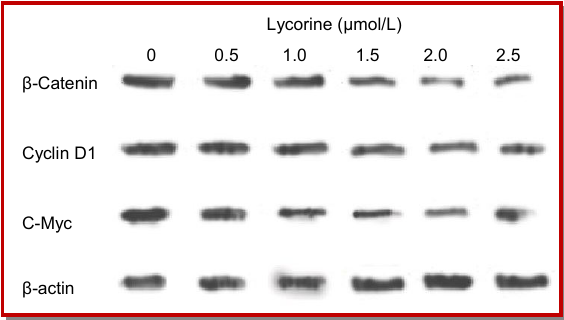
Figure 3: Lycorine blocks Wnt/ (cid:451) - catenin signaling pathway in MDA-MB-231 breast cancer cells in a dose-dependent manner